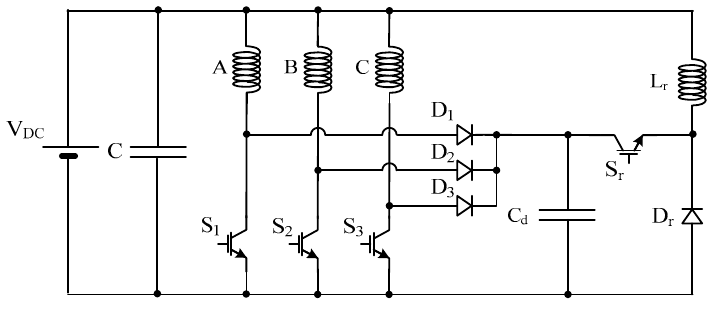
Figure 7. C-Dump topology.